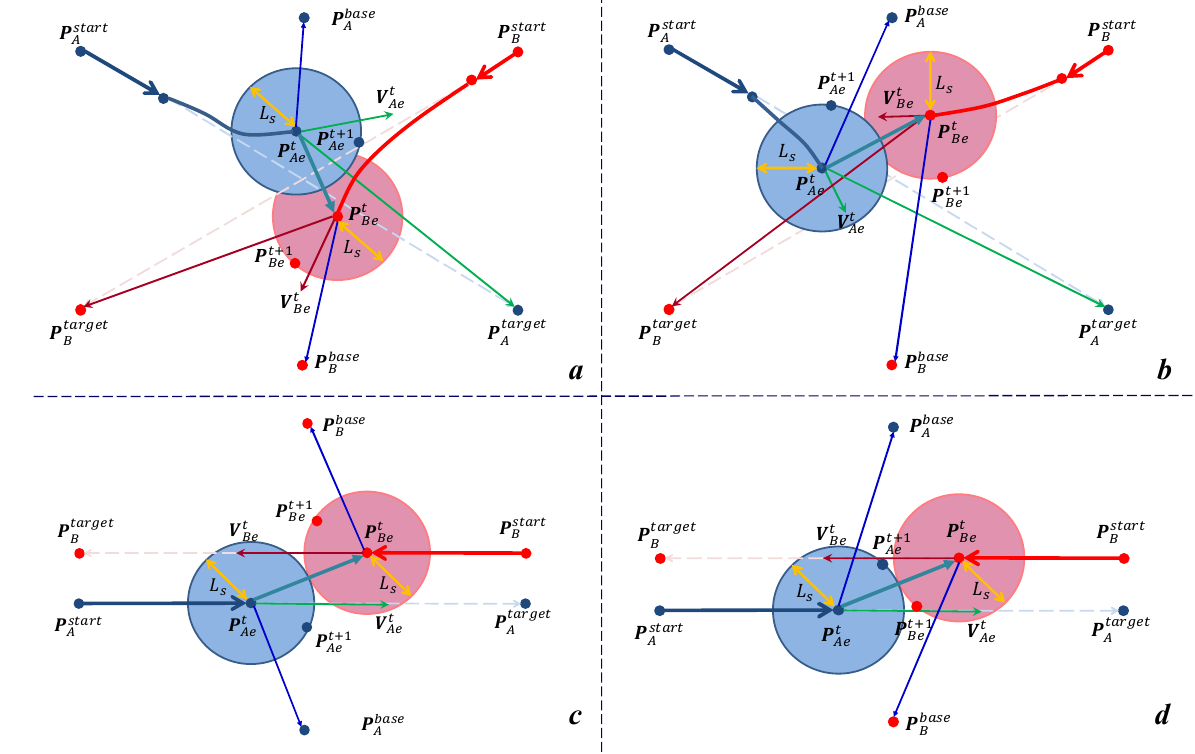
Figure 3. Influence of the relative positions of the dual manipulator EEFs on the obstacle avoidance path-planning strategy. The upper part of Figure 4 (picture a , b ) of the dual manipulator system have crossed initial paths, while the bottom half ( c , d ) is set to initial parallel paths. Meanwhile, the left half of picture a and c corresponds to the interval scenario, ( b , d ) fall under the interact scenario specified in Figure 4. Different initial paths and coexistence scenarios give rise to various choices of obstacle avoidance points ( ∈ {,}) . For the interval scenario, the relative position vector ( − ) between manipulator B and A is outside the working space of manipulator A (consisting of vectors ( − ), ( − ) and ( − ) together). In this case, it is only neces-